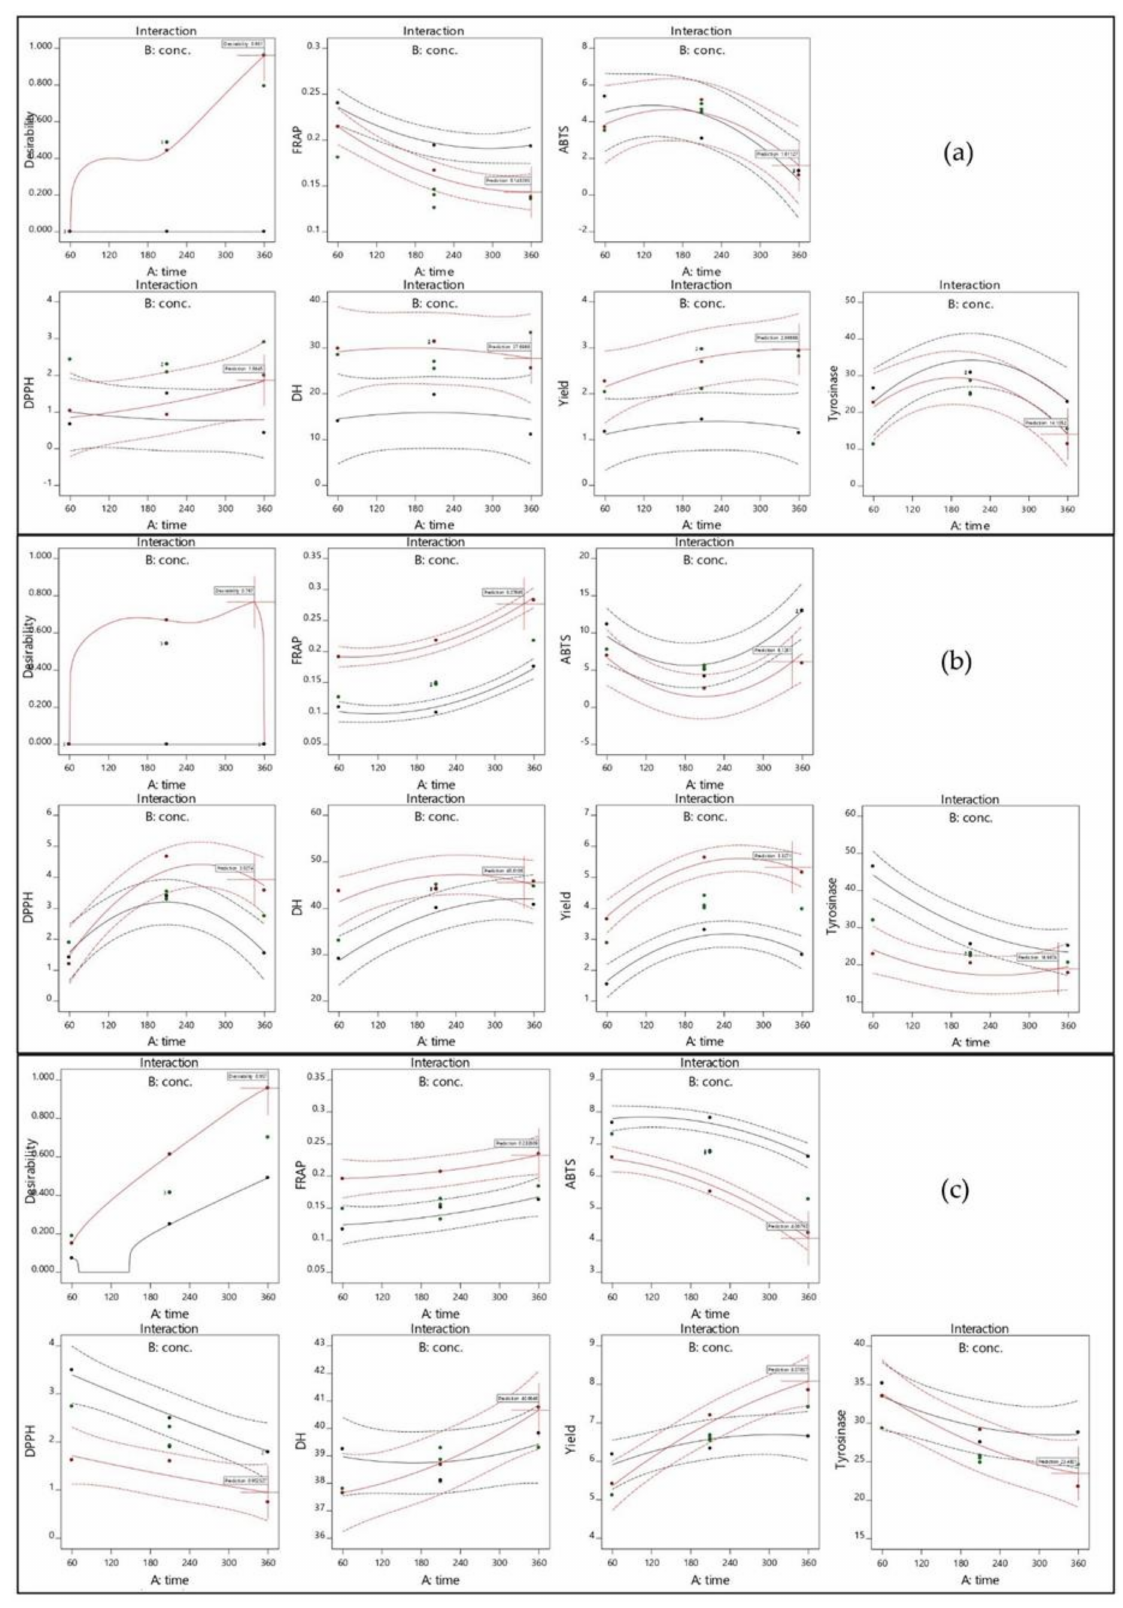
Figure 3. Plot of the interaction effect for hydrolysis time (X 1 ) and enzyme concentration (X 2 ) on DH, yield, DPPH and ABTS radical scavenging, FRAP value, and tyrosinase inhibition activity using alcalase ( a ), flavourzyme ( b ), and papain ( c )